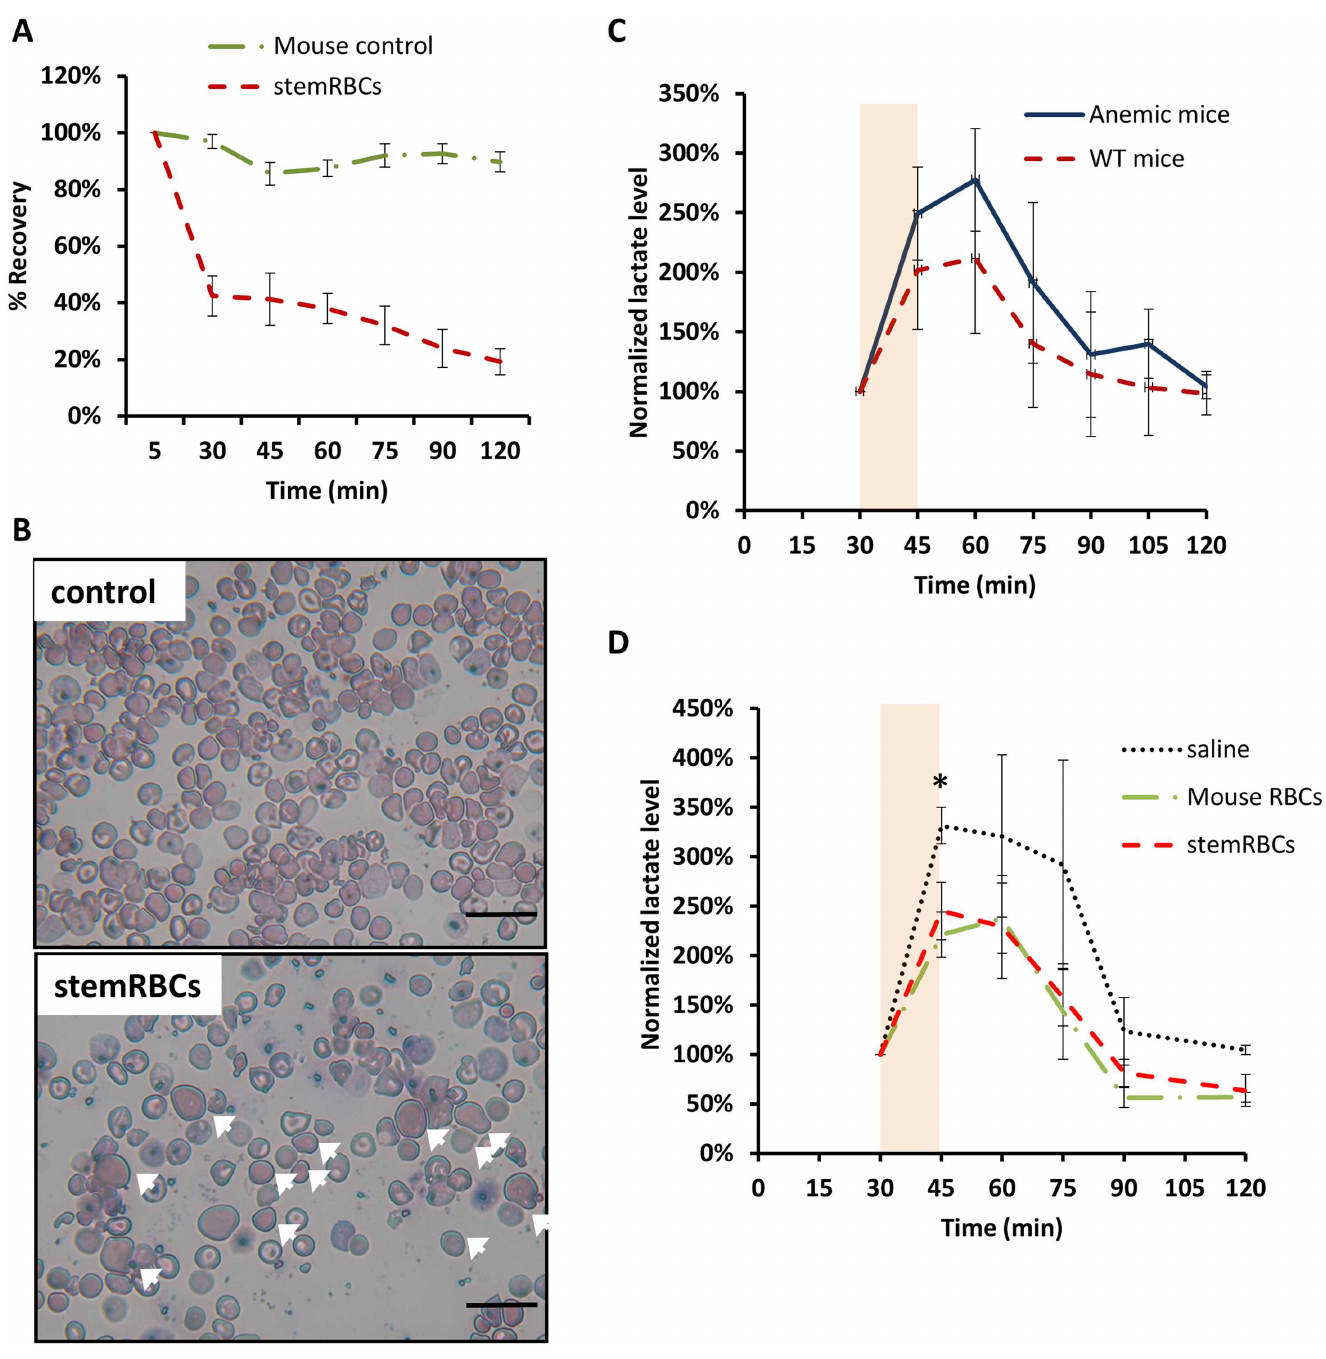
Fig 4. Functional analysis of stemRBCs in vivo . (A) In vivo recovery of day 18 stemRBCs and WT mouse control RBCs (n = 4–6 per group) in anemic SCID mice. CFSE-labeled cells were infusedby i.v. injection(tail vein). Mouse wholeblood was collectedat the indicatedtimes and analyzedby flow cytometry. Recovery was set to 100%at the 5 min time-point. (B) Representative images of mouse wholeblood collectedat 5 minutes post-injection of murinecontrol RBCs or stemRBCs (arrows). Scale bar: 20 μ m. (C) The animal model of oxygen function was validatedby subjectinganemic C57BL/6J (Hbb th3/+ ) and wildtypeC57BL/6Jmice (n = 3 per group) to a 15 min swim (shown as an orangerectangle)in 26˚C water and ambientair. Lactate levels were measuredpre- and post-swim, and every 15 min thereafter. Oxygen deficit due to exercise is reportedin mice through a corresponding spike in lactate level. (D) stemRBCs, along with controls (saline and wild-typemouse RBCs; n = 3–5 per group) were introduced into C57BL/6JHbb th3/+ mice. After 30 min, lactate was measured,and mice were subjectedto a 15 min swim. Lactate was measuredpost-swim and every 15 min as indicated. Data points are means and error bars show SEM. ( * = p <